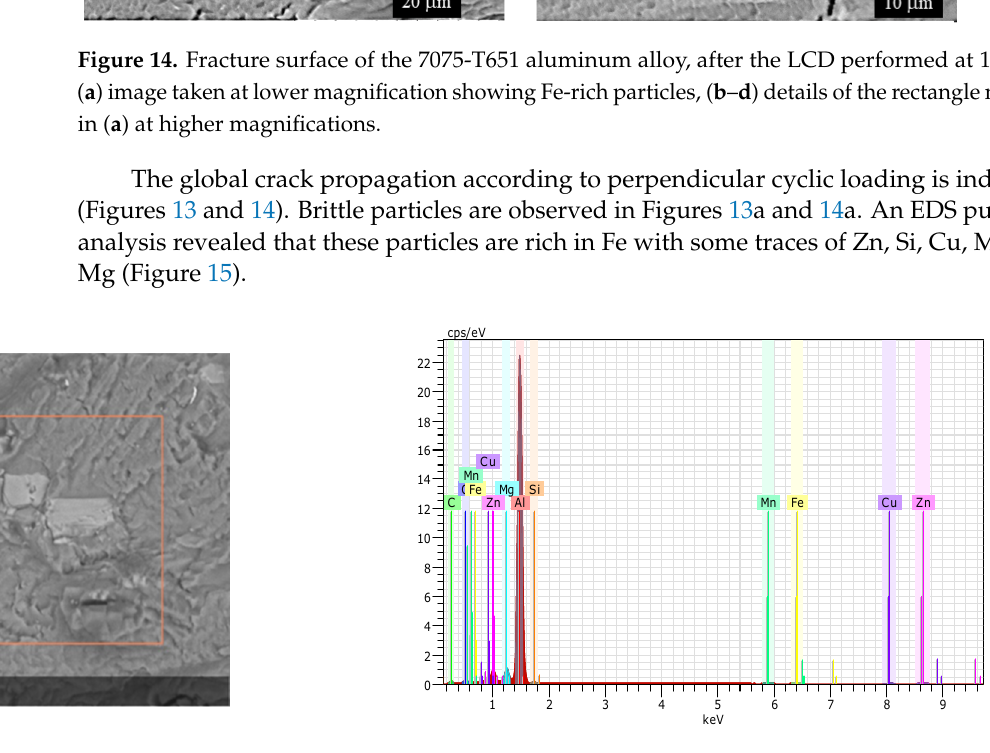
Figure 15. Spectra of the EDS analysis performed on the particles.